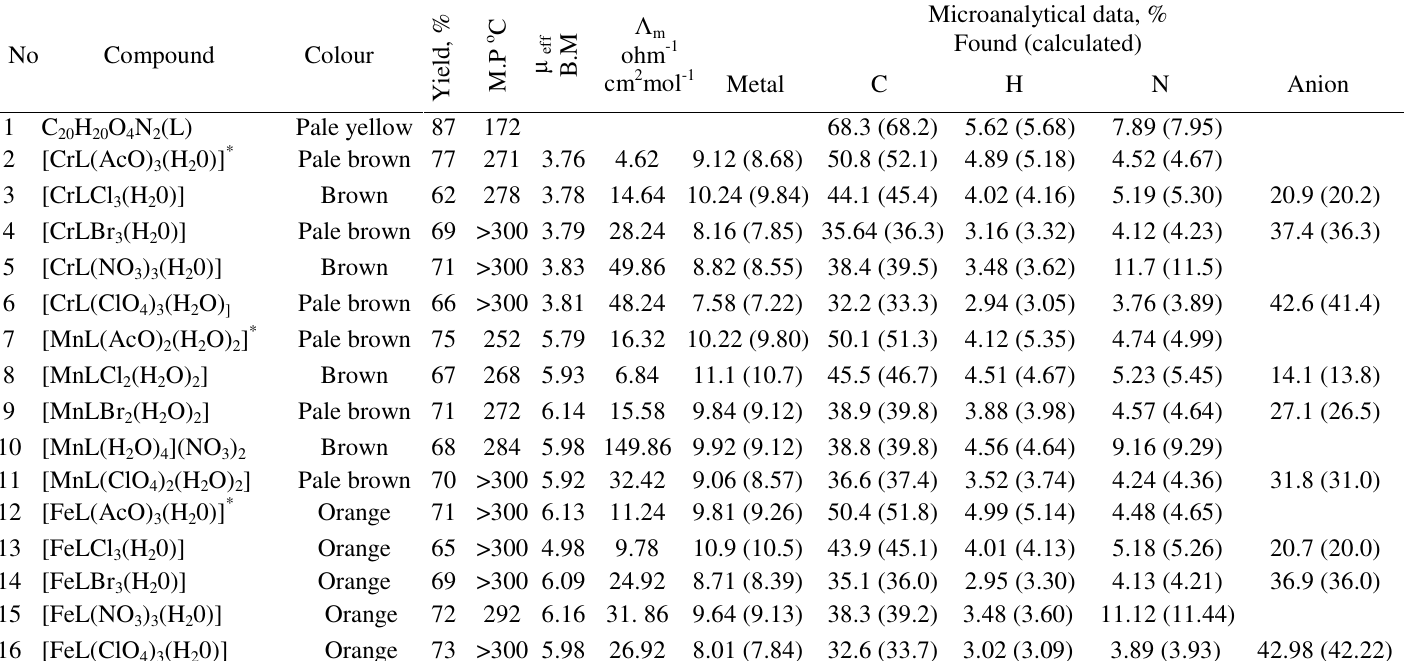
Table 1. Formulae, general properties and micro analytical data of ligand and complexes